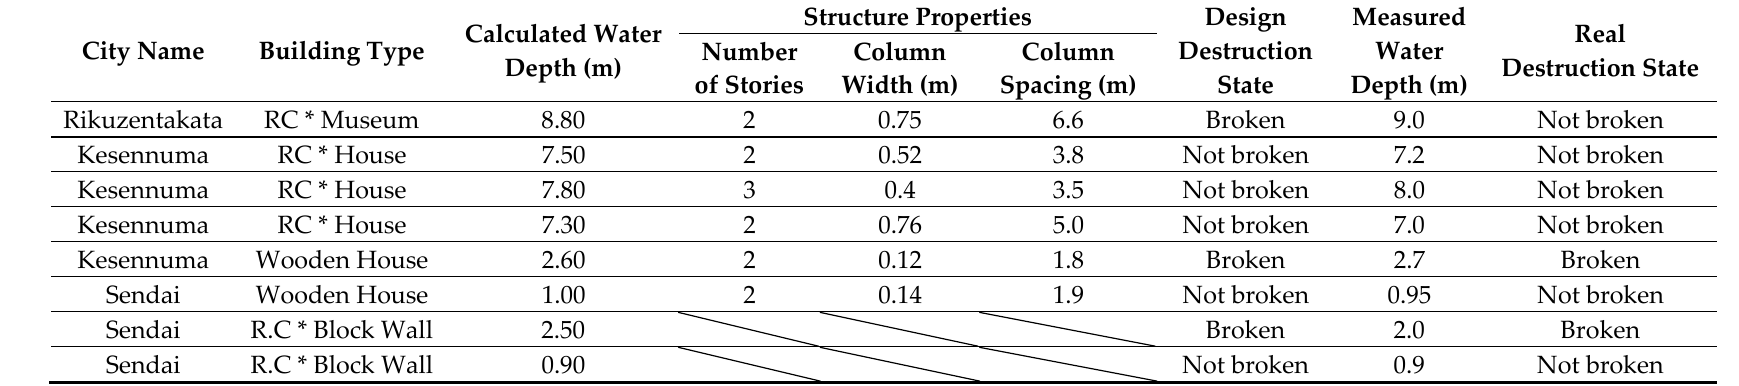
Table 5. Verification examples of building destruction due to the 2011 Great East Japan